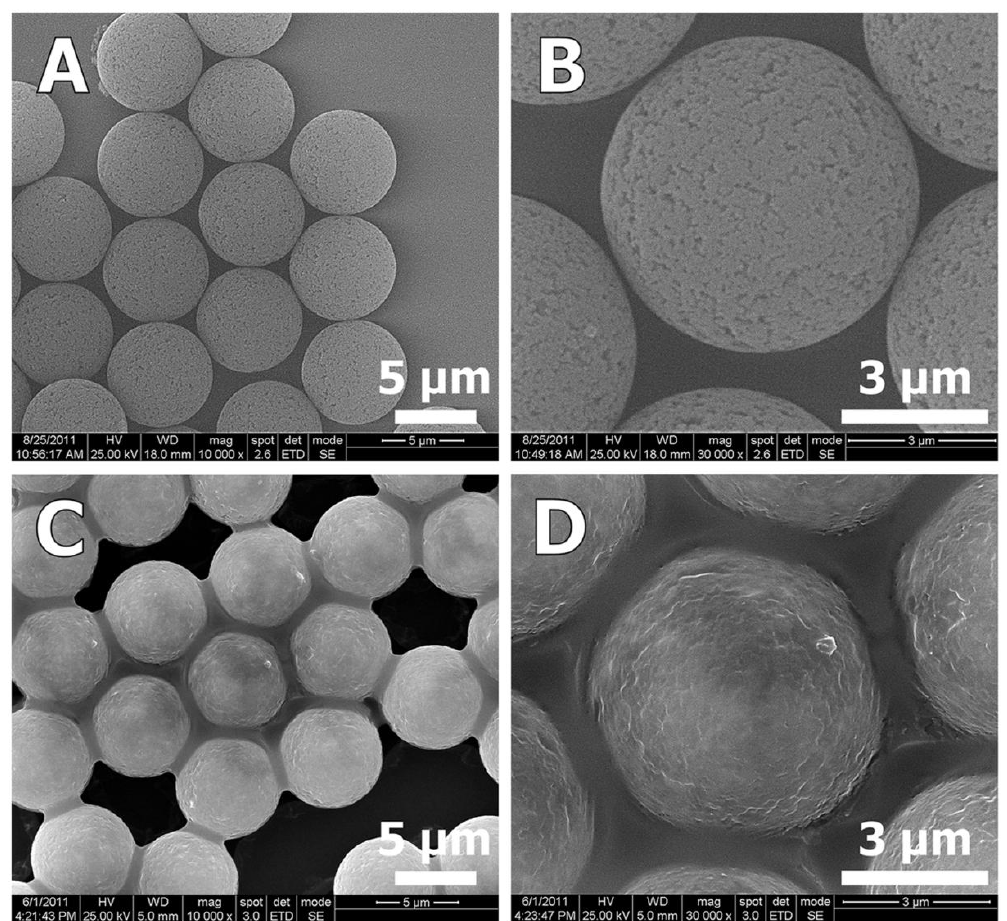
Figure 8. SEM images of PDVB microspheres ( A , B ) and ZnCl -PDVB composite 2 microspheres ( C , D ). These pictures clearly indicate that the inter-pores of the PDVB microspheres were covered by ZnCl 2